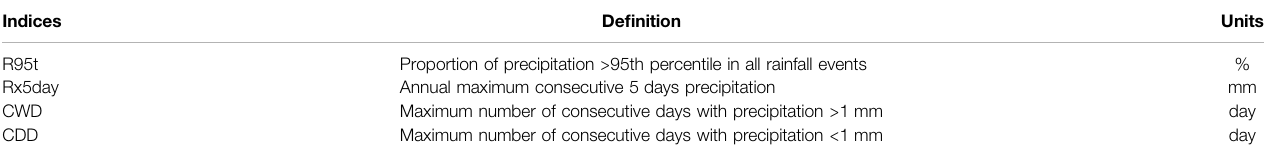
TABLE 1 | De fi nitions of extreme precipitation